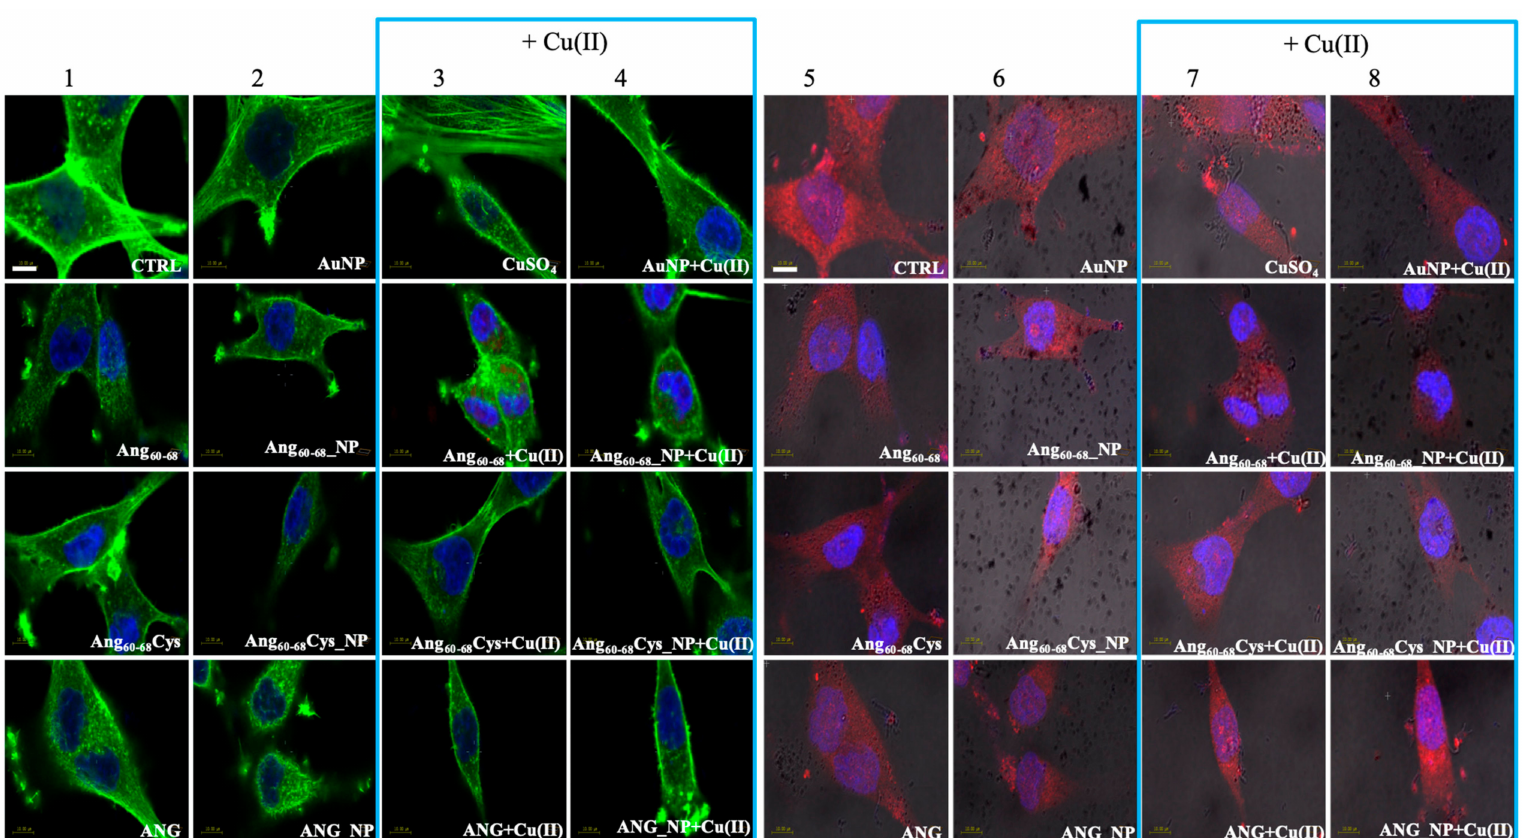
Figure 4. Confocal micrographs of A172 cells. Actin Green ® 488 (in green, ex / em = 488 / 500–530 nm) and Hoechst33342 (in blue, ex / em = 405 / 425–475 nm) were used as F-actin and nuclear markers, respectively. Antibody against angiogenin shows angiogenin localisation in red (ex / em = 543 / 560–700 nm) and micrographs are merged with optical bright field images (in grey). Before treatments, cell were rinsed with fresh culture medium and incubated for 2 h with basal culture medium (control: CTRL) and in culture medium supplemented with: Ang 60–68 (30 µ M), Ang 60–68 Cys (30 µ M); ANG (100 nM), AuNP (9.4 nM = 1.4 × 10 8 NP / mL), Ang 60–68 _NP (1.4 nM = 4.0 × 10 6 NP / mL, [Ang = 2.8 × 10 − 12 M), Ang = 4.0 × 10 6 NP / mL, [Ang = 2.6 × 10 − 12 M), ANG_NP (1.2 nM = 3.4 × 10 6 NP / mL, 60–68 ] 60–68 Cys_NP (1.4 nM 60–68 Cys] [ANG] = 0.2 × 10 − 12 M). Scale bar = 10 µ